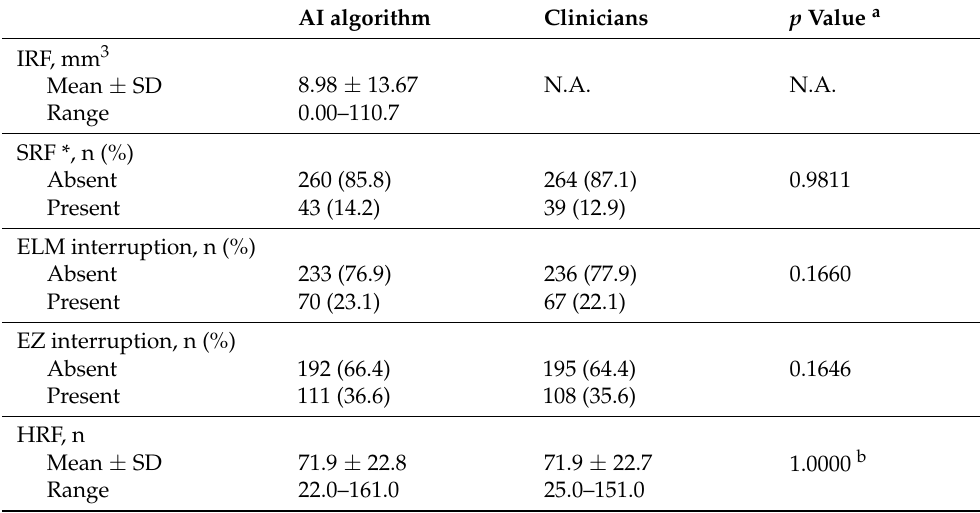
Table 2. Overview of the main spectral domain optical coherence tomography (SD-OCT) features. AI